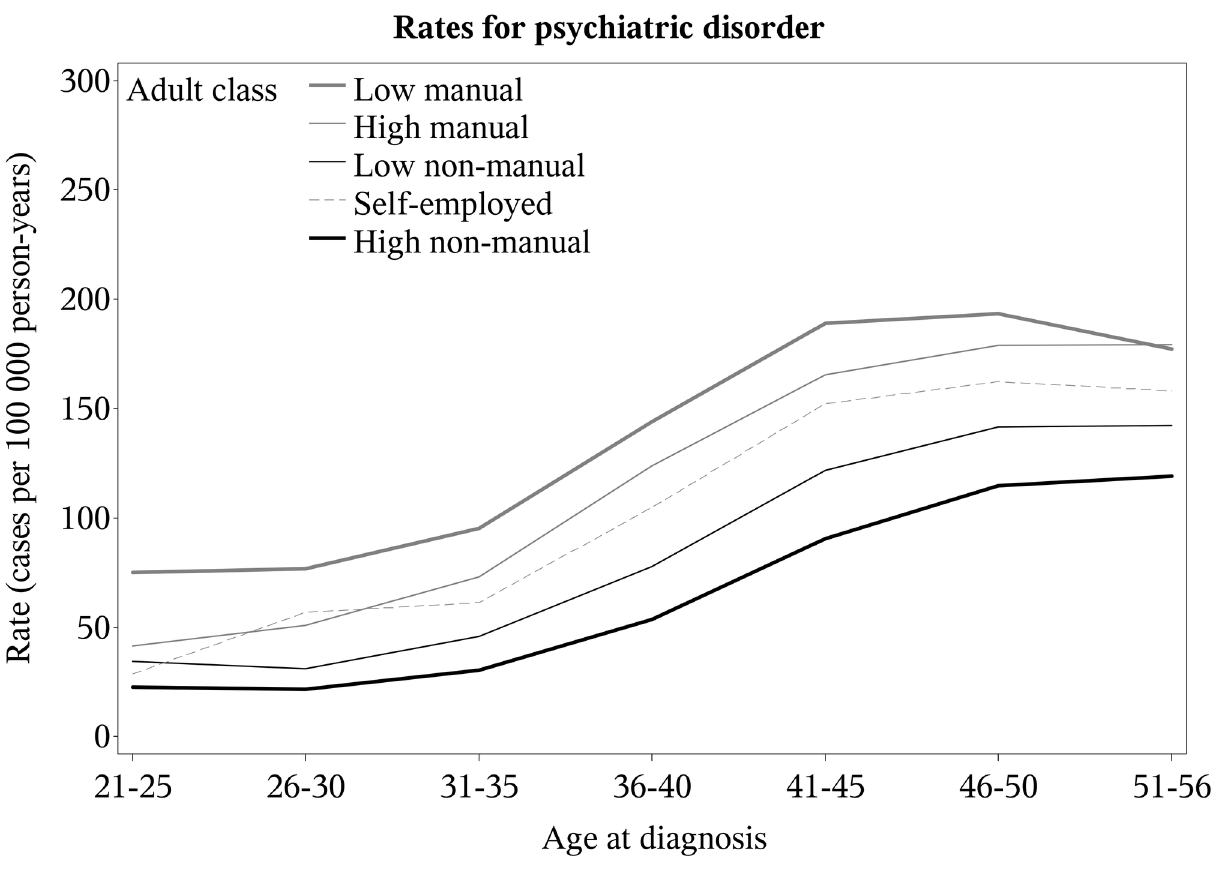
Figure 2. Rate of psychiatric disorder (cases per 100 000 subjects) versus age at diagnosis. Rate developments by adult social class at cohort entry.